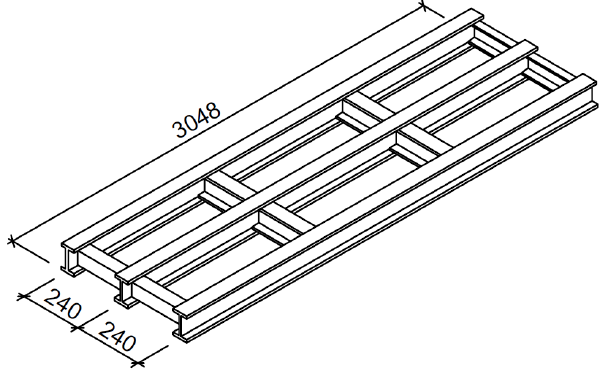
Figure 4. Scheme of three ‐ stringer panel.